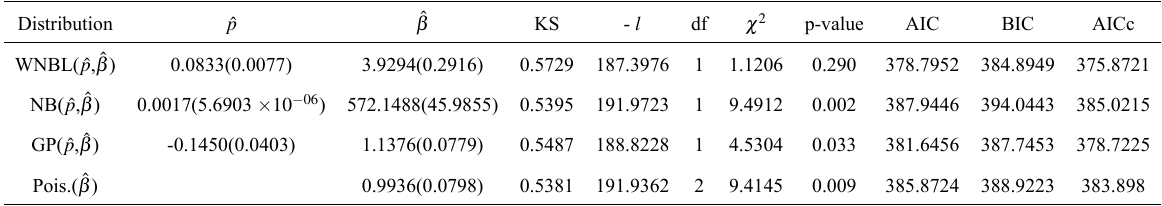
Tests Summary for data set